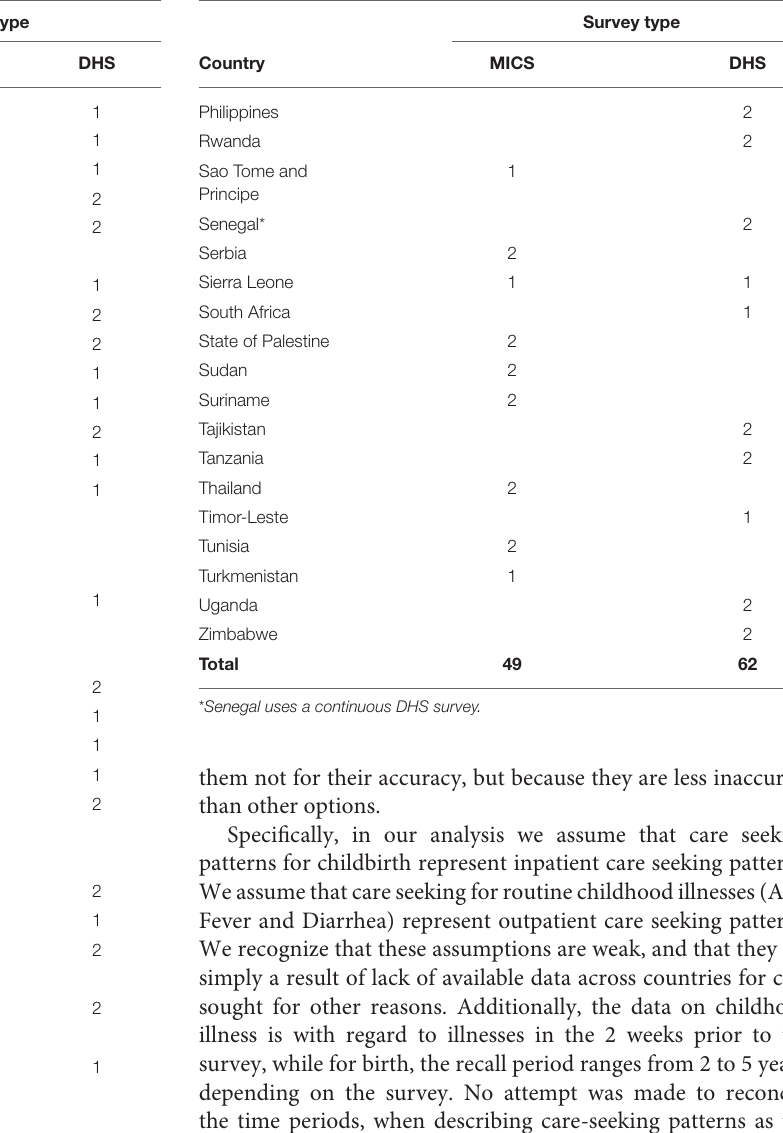
TABLE 1 | Country and data sources